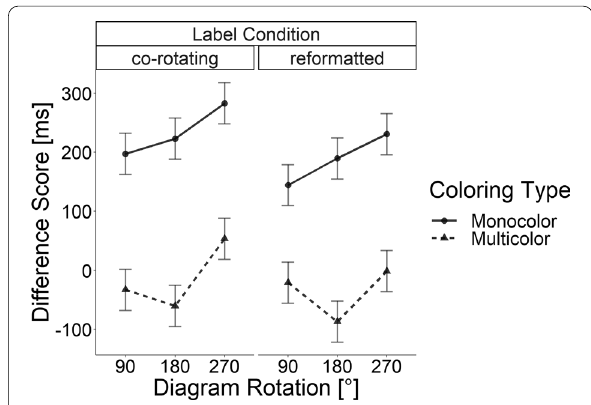
Fig. 7 Results of Experiment 3: Mean differences of the response onset relative to the baseline without rotation. Error bars are based on Fisher’s Least Significant